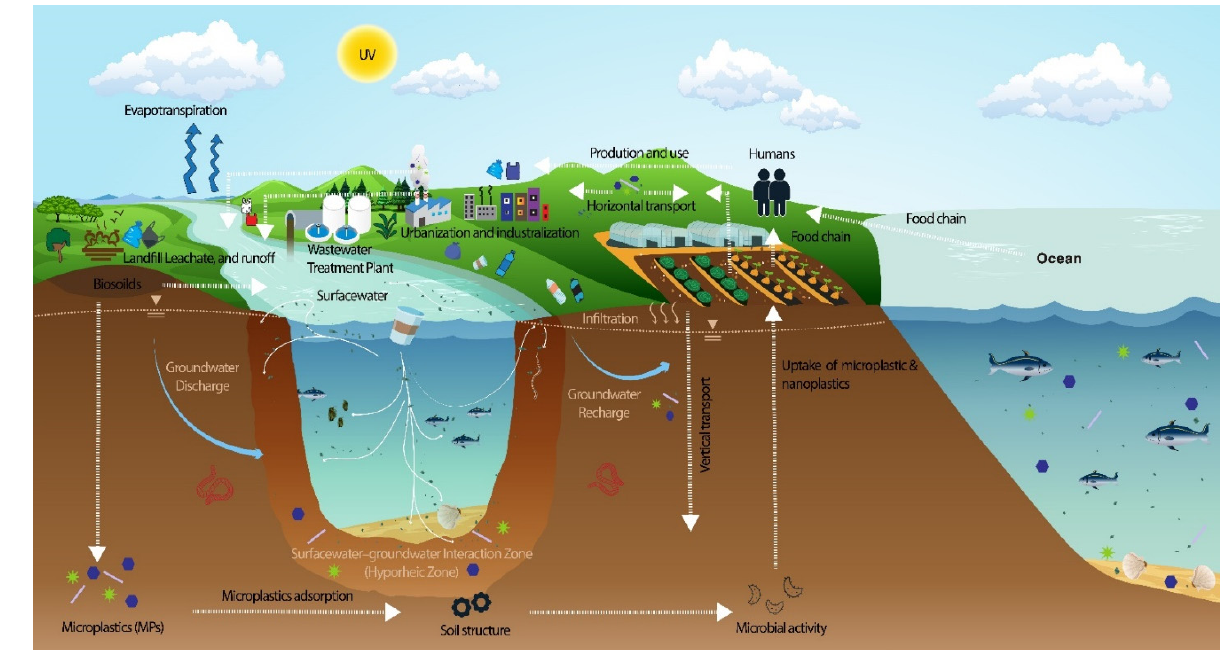
Figure 4. Potential microplastic occurrences and sources for entrance and transport into the subsurface water and groundwater environment. Adapted from [66]. Table 1. Recent research on microplastics in groundwater and